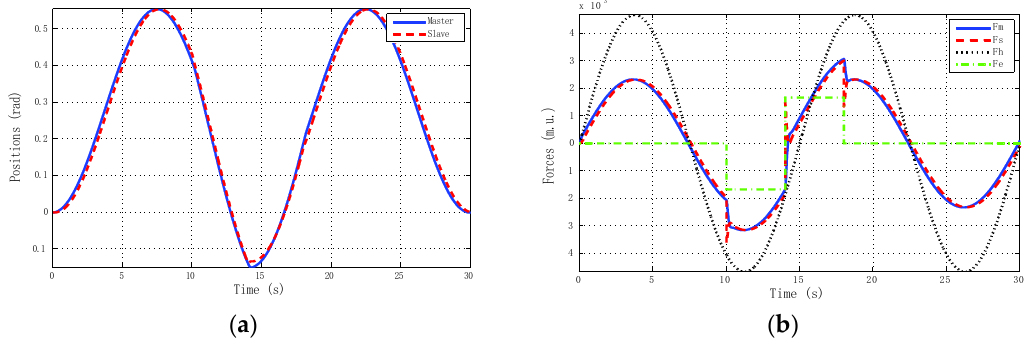
Figure 5. Simulated sine reference force: PE control scheme with hmax = 0, d = 0. ( a ) Positions; ( b ) Forces.